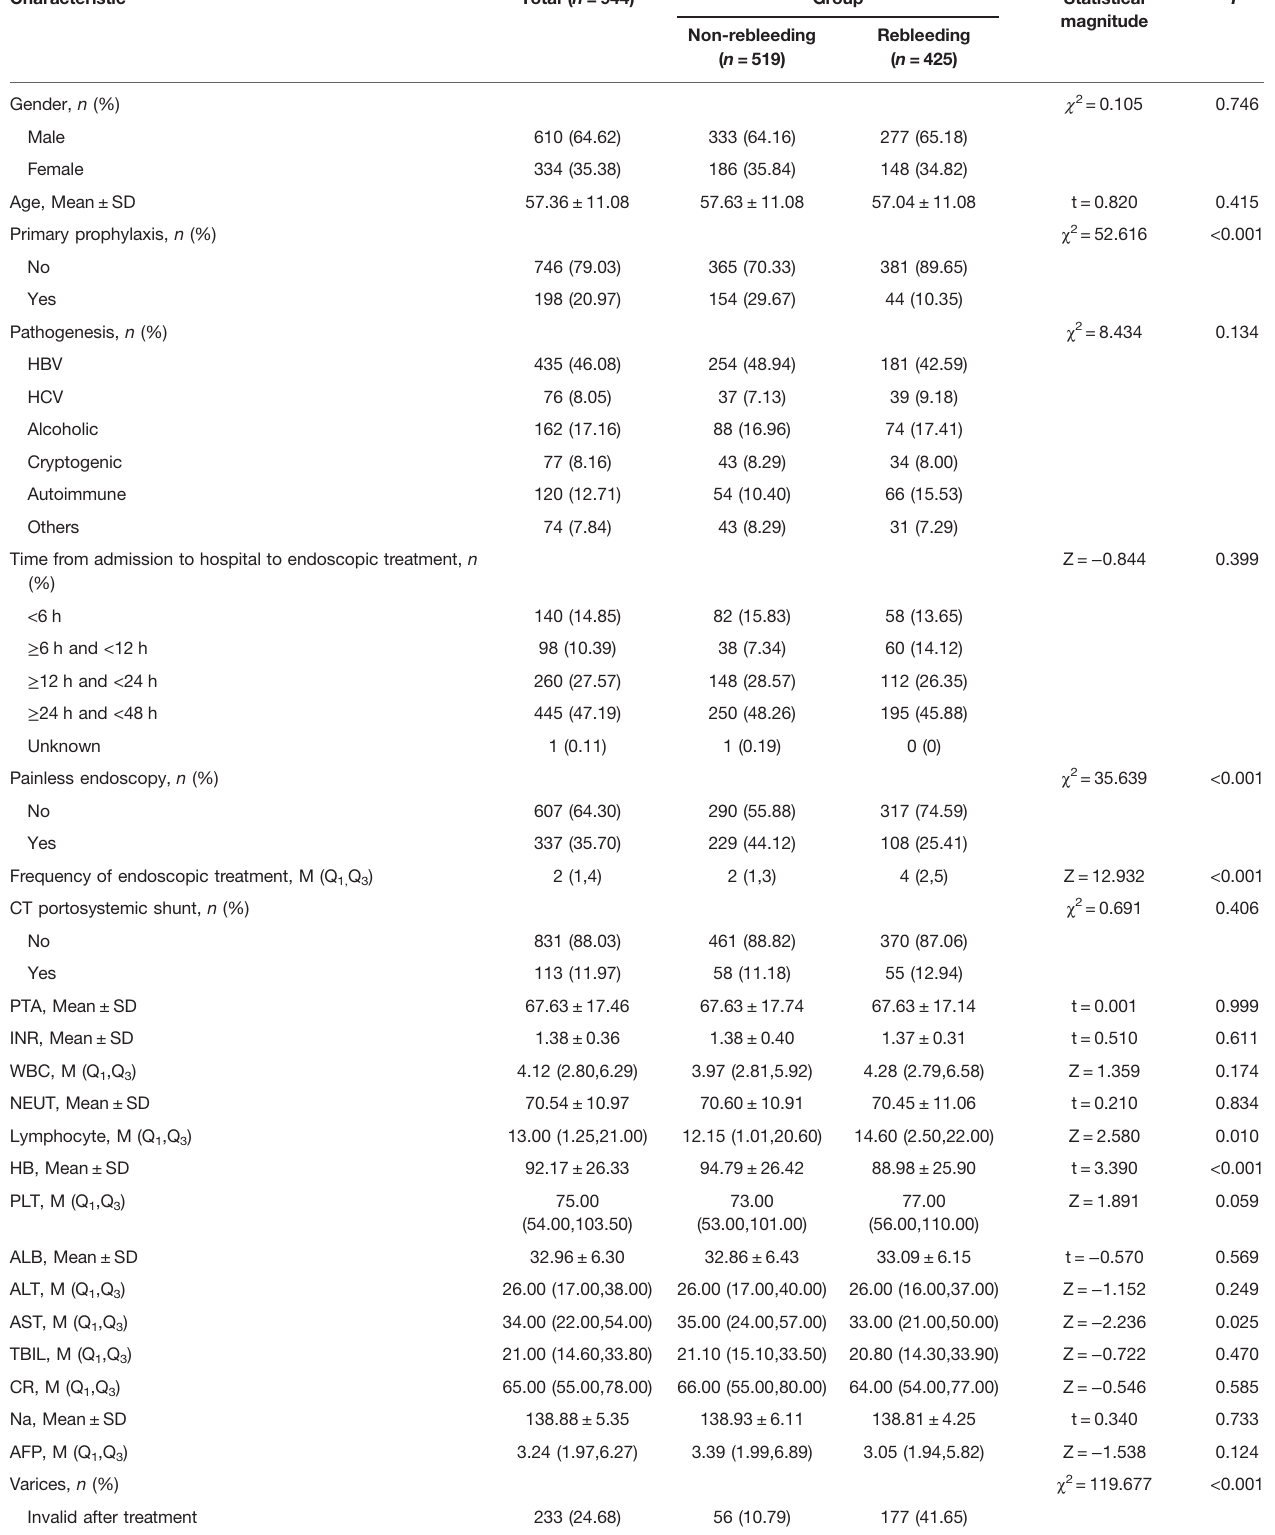
TABLE 2 | Comparisons of the data in patients between two groups. Characteristic Statistical